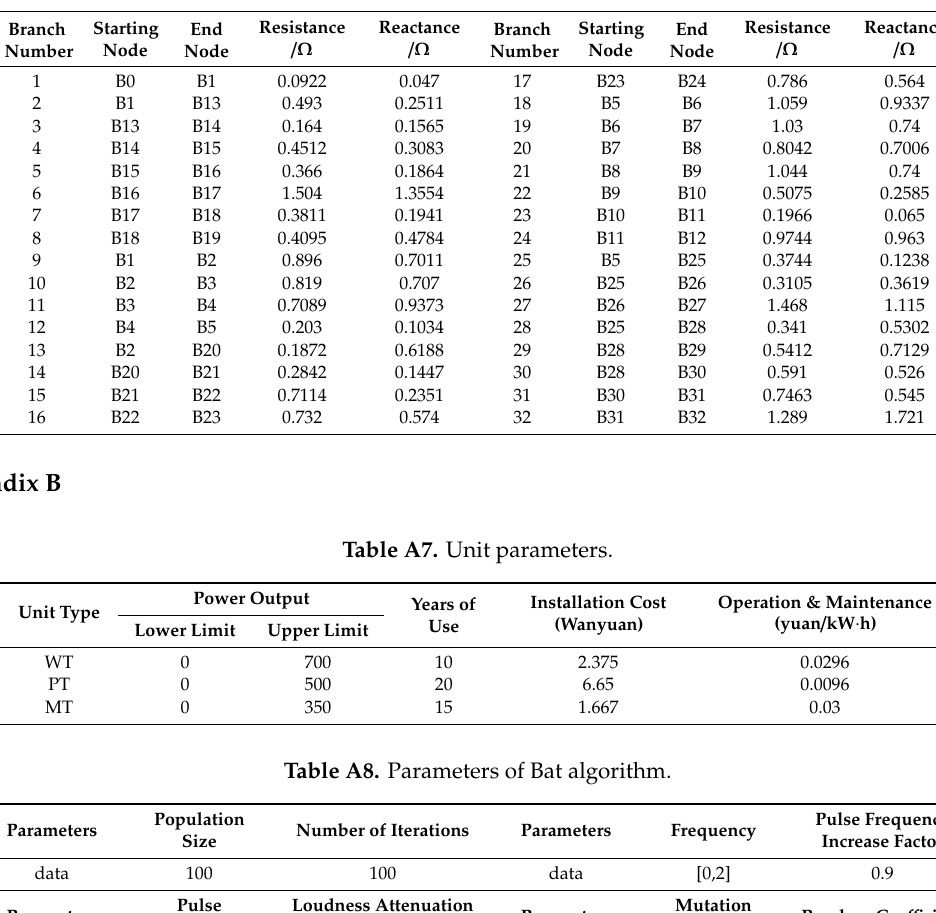
Table A6. The resistance parameters of the IEEE 33 network.